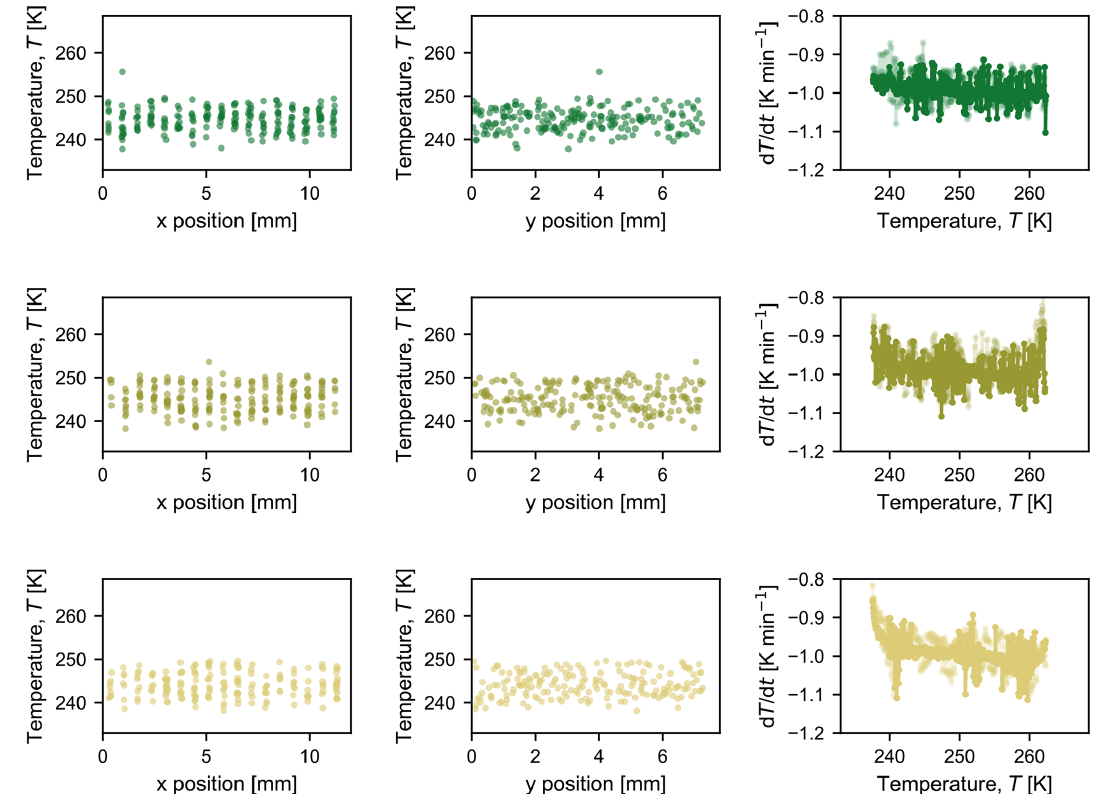
Figure B2. Compilation of observed freezing temperatures at each x and y position to illustrate that there is no discernable spatial bias in freezing temperature for each experiment conducted with the microcline suspension shown in Fig. 4 (from top to bottom: i, ii, and iii). The third graph in each row shows the measured cooling rate at each temperature at which a picture was taken; the opaque line indicates the cooling rate measured by the thermocouple that was used as input to the control loop, and the semi-opaque line indicates the cooling rate measured by the second thermocouple in the